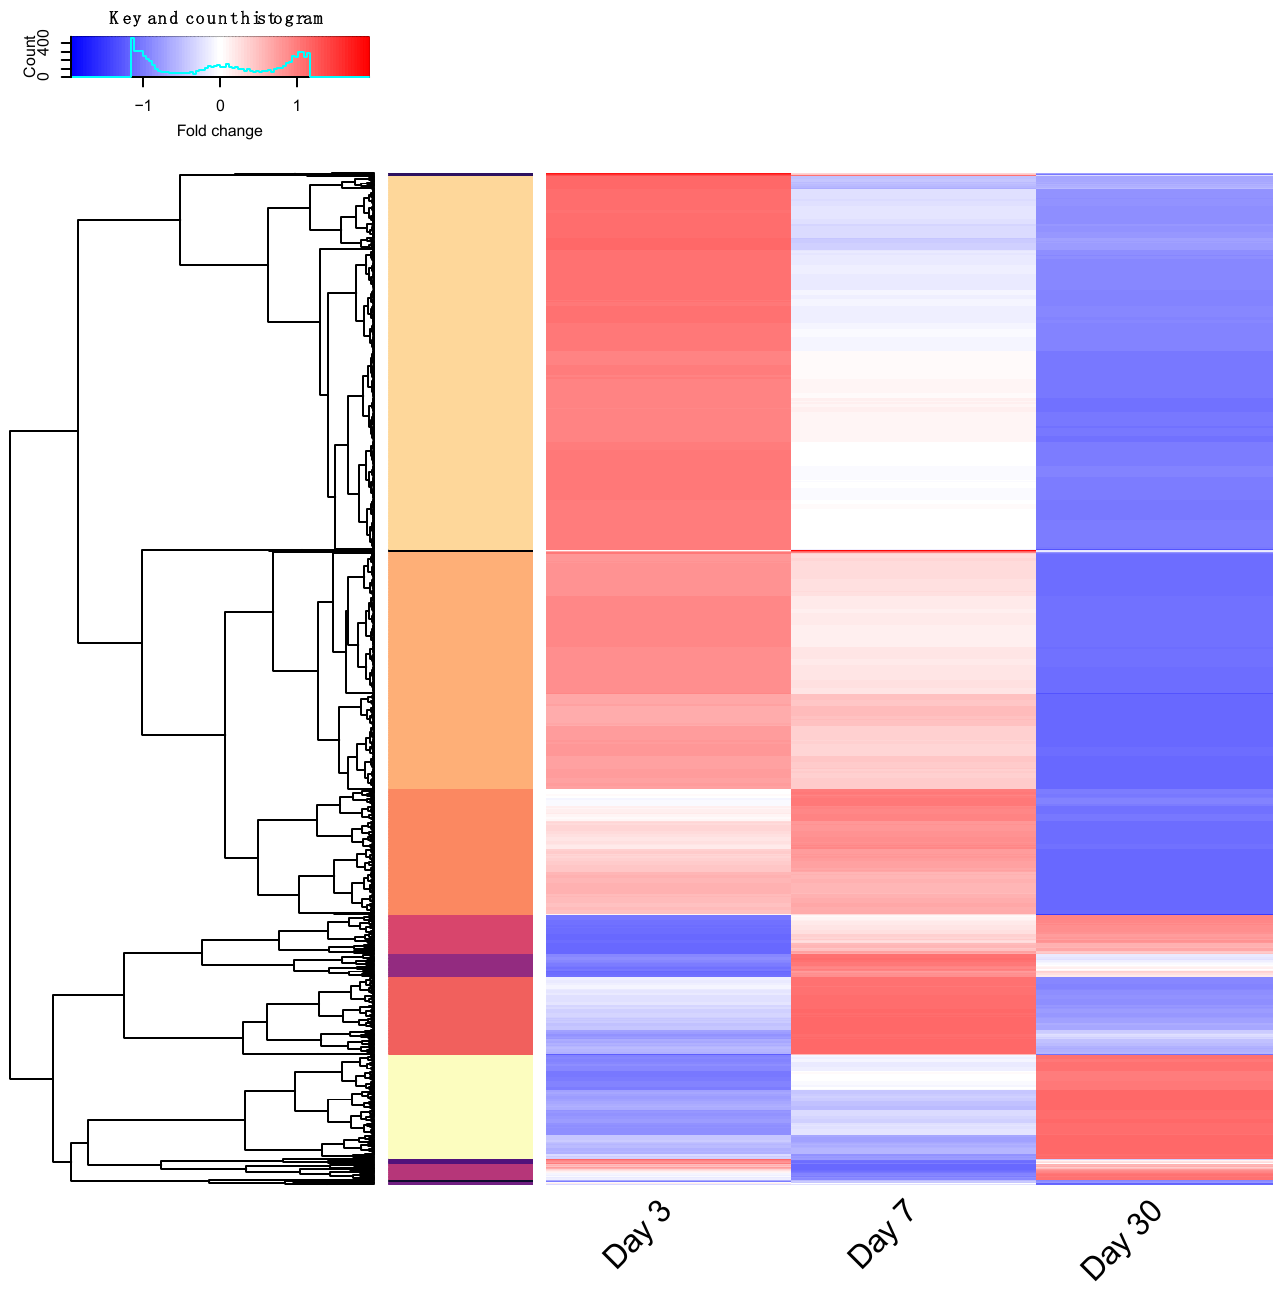
Figure 7. RNAseq analysis gene clustering. Genes showing differential expression over three time points scaled per-gene. Hierarchical clustering was performed, and thirteen distinct groups determined by tree height are illustrated by color in the left vertical bar. Fold change in gene expression is represented by color over days 3, 7, and 30; low—blue to high—red. Scaled expression data are listed in Table S3. Genes with common expression profiles were assessed for protein pathway enrichment. Query summary and significant associations listed in Table S4.